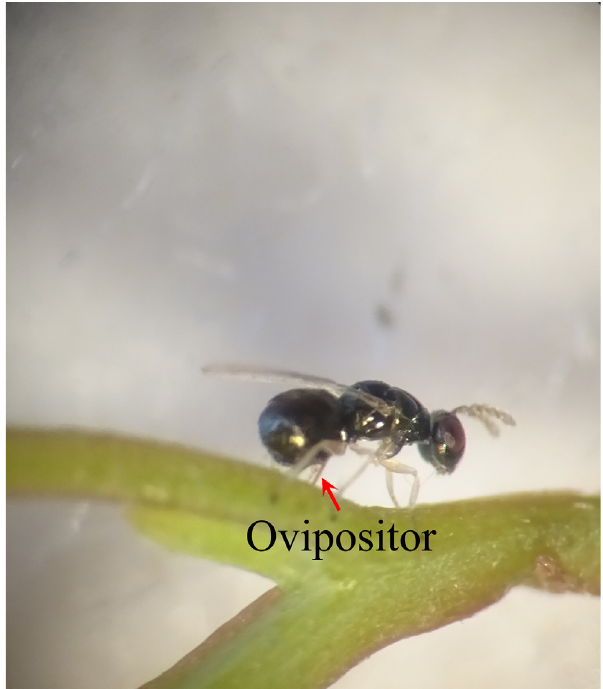
Figure 2. Newly emerged female of Leptocybe invasa